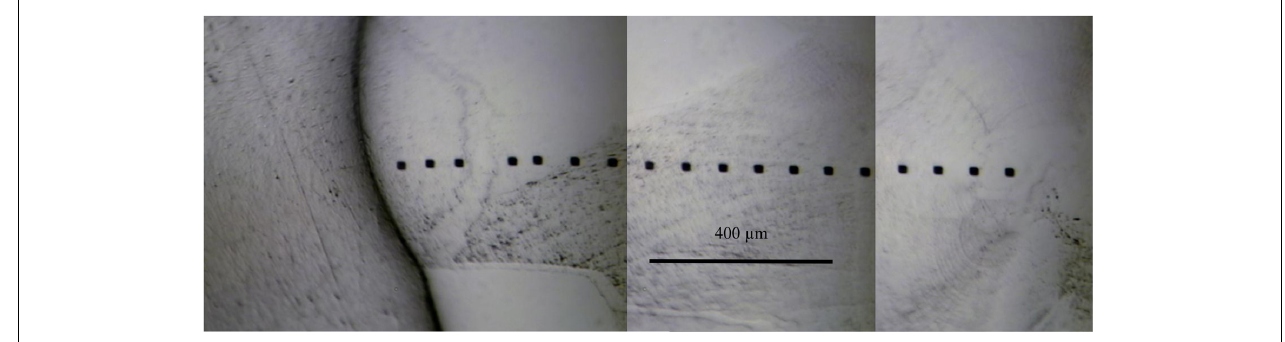
FIGURE 3 | A merged photo of an otolith showing the spots taken on a transverse from the core along the distal radius toward the